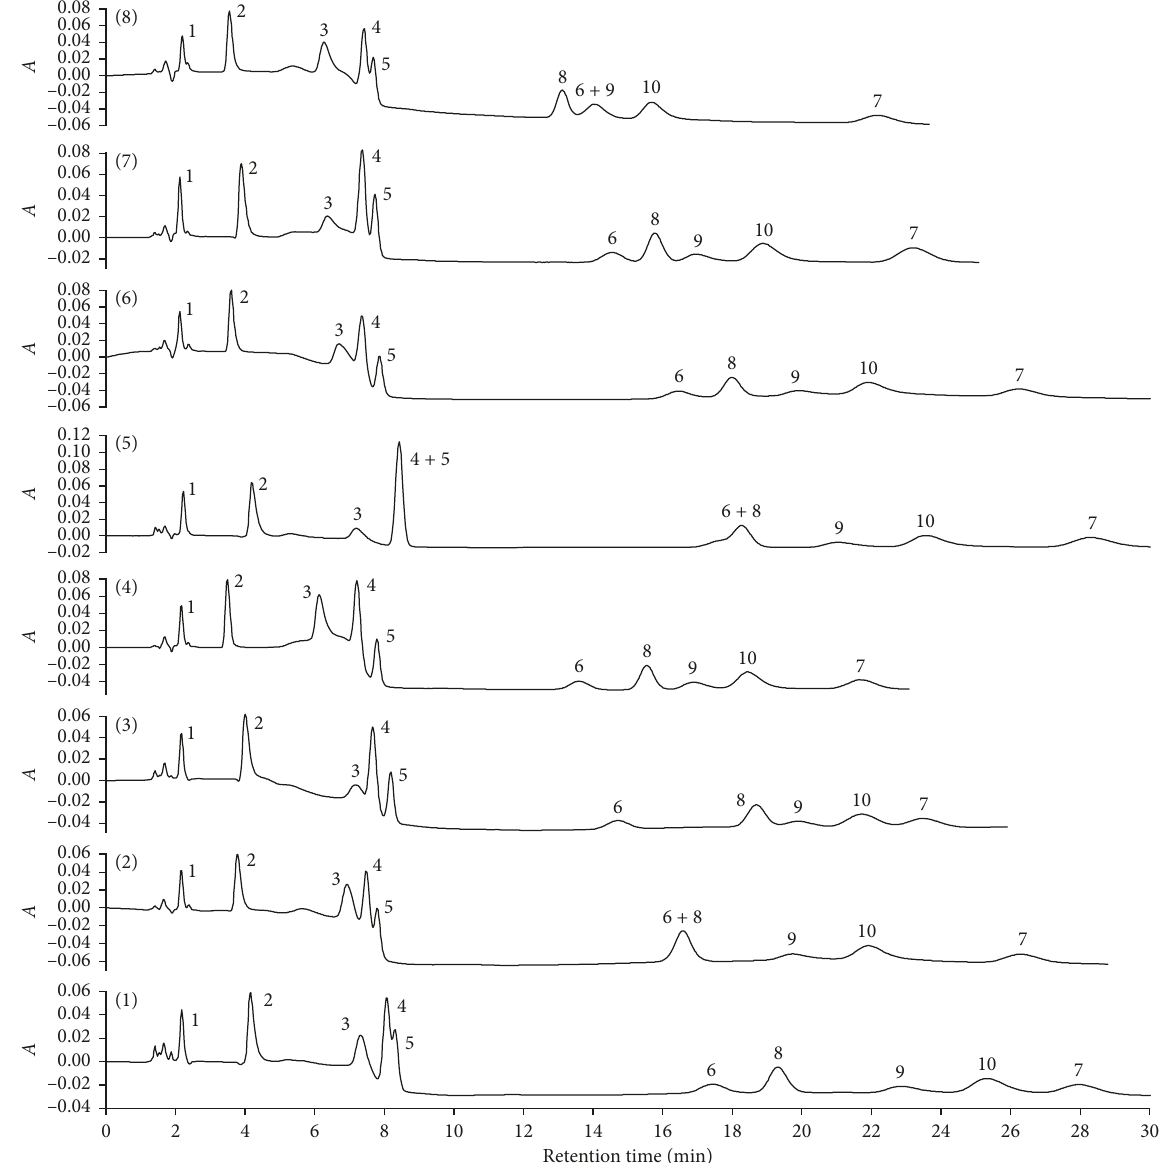
Figure 4: Chromatograms obtained from factorial design 2 3 . Numbers from (1) to (8) correspond to the experimental condition number. A in the y -axis is the